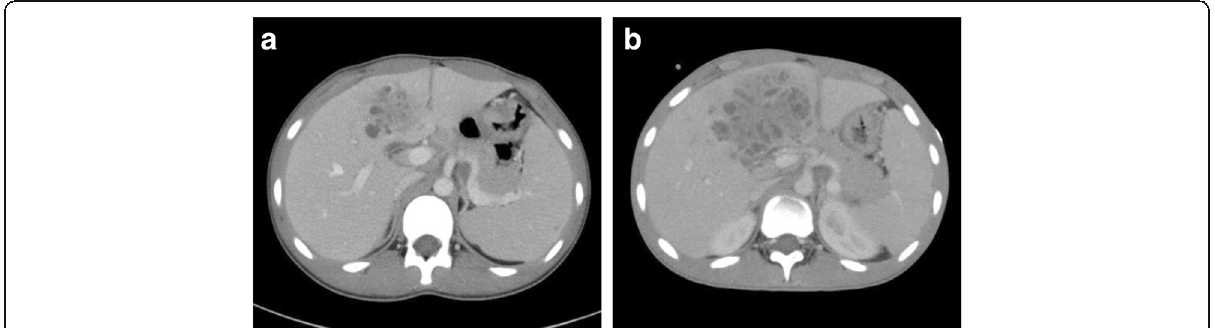
Fig. 1 a Enhanced computed tomography (CT) image. CT image showing a multilocular mass measuring 52 mm × 34 mm in hepatic segment 4a and 5 (S4a + 5). b CT findings on day 28. The abscess has not changed since the previous scan and exhibits